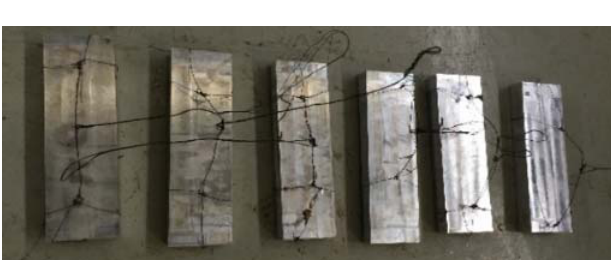
Figure 2. The sample surface indicating the coordinate system. Figure 1. Quenching experiment.